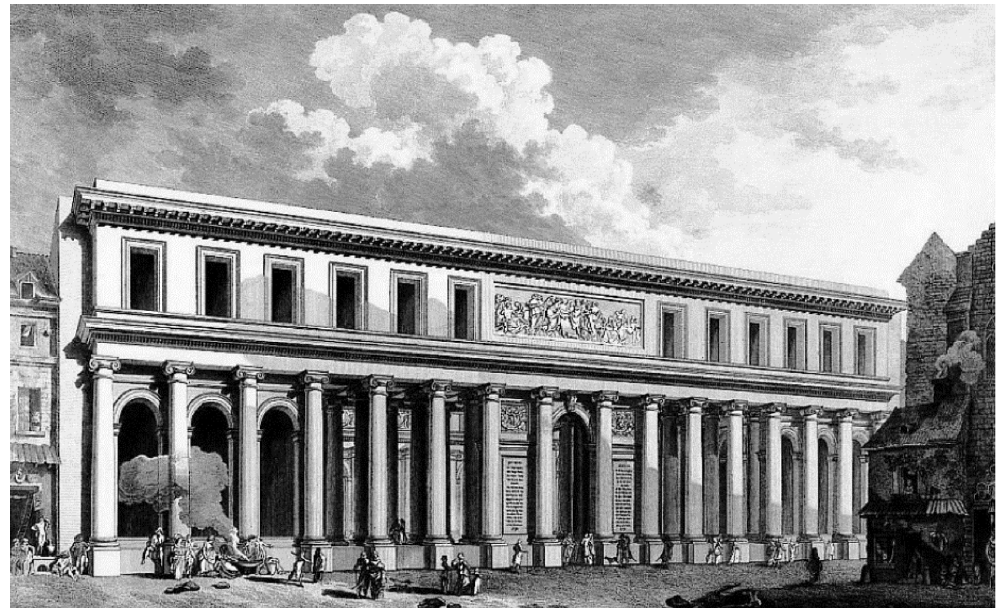
Fig. 2. In 1775, the Academy moved to new premises. This building, designed by the architect Gandouin (12, rue de l'École de Médecine), later housed the Faculty of Medicine of Paris. After 1968, it became the headquarters of the René Descartes University.